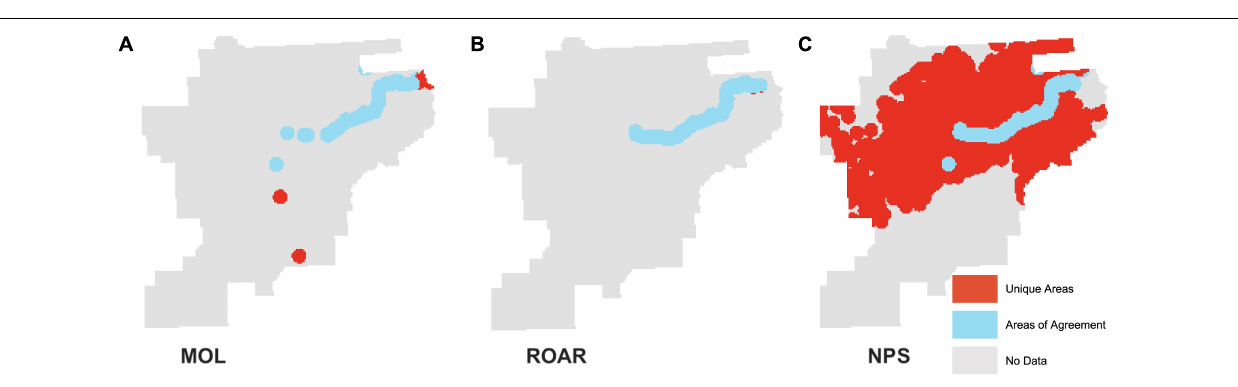
Frontiers in Ecology and Evolution |